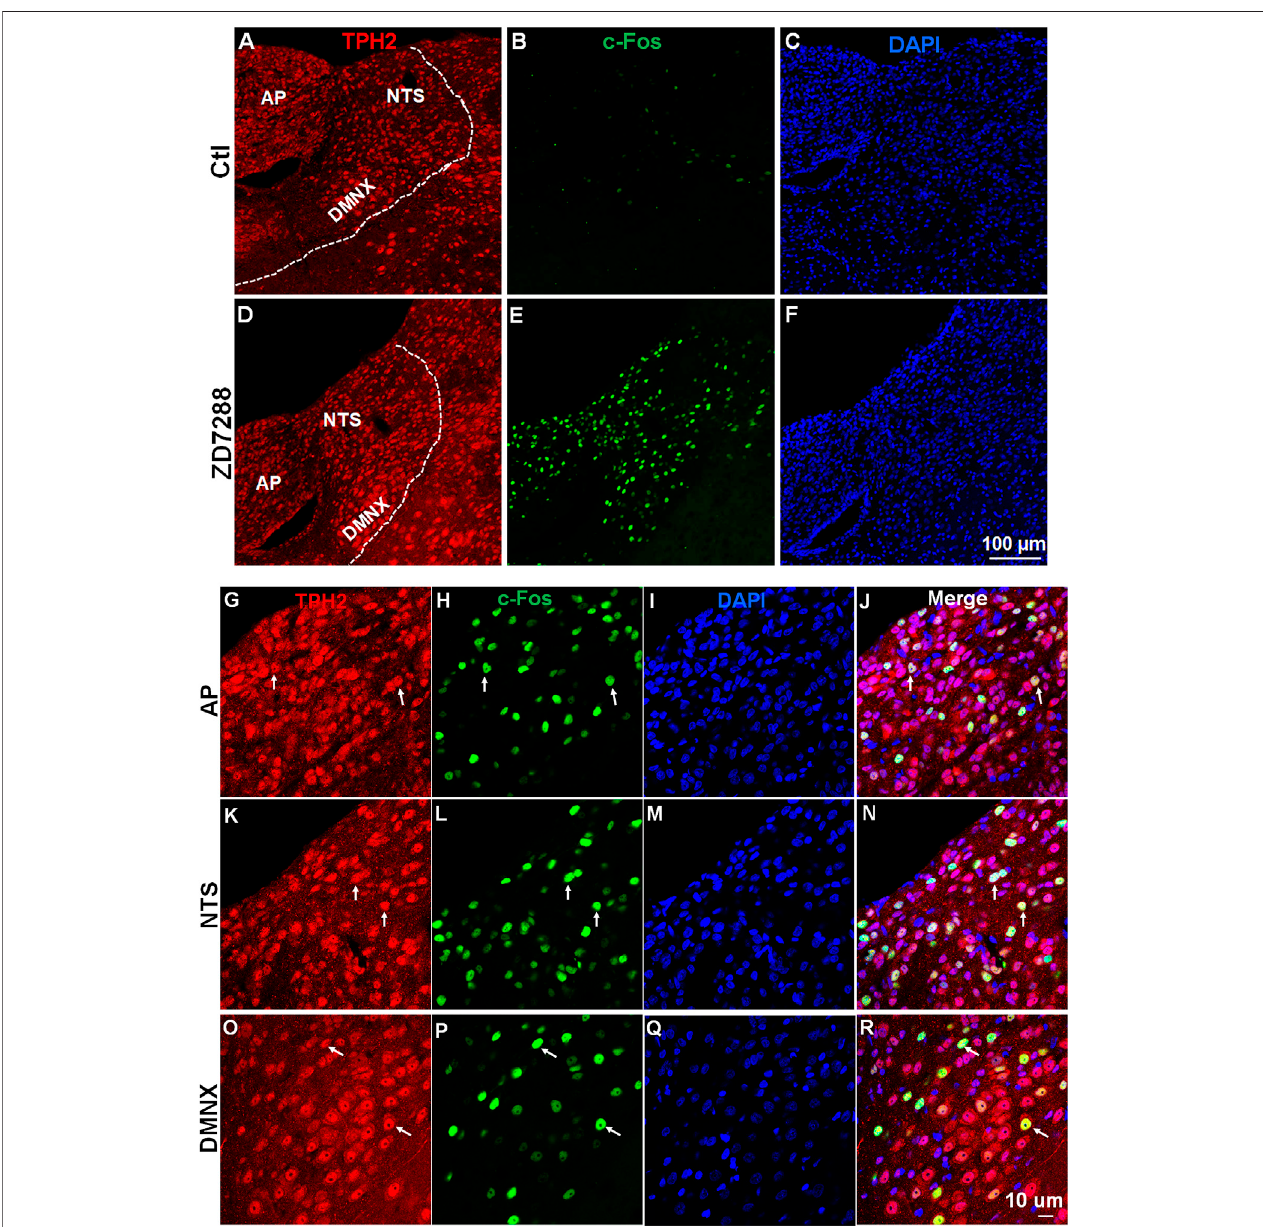
FIGURE7| ZD7288increasesc-Fosexpressionofserotoninneuronsintheleastshrewbrainstemdorsalvagalcomplex. (A – F) Tryptophanhydroxylase2(TPH2)is therate-limitingenzymeinthesynthesisofneuronalserotonin.Representativeimages(20x)showinganti-TPH2,anti-c-Fosandmergedimmuno fl uorescencestainingin vehiclecontrolsandshrewsadministeredwithZD7288(1 mg/kg,i.p.)( n (cid:2) 3shrewspergroup).Scalebars (cid:2) 100 μ m.(G – R)Representativehighermagni fi cationimages ( × 60)showingc-FosexpressingevokedbyZD7288(1 mg/kg,i.p.)localizedinTPH2positiveserotoninneuronsofthebrainstemdorsalvagalcomplex,composed of the area postrema (AP), the nucleus tractus solitarius (NTS) and the dorsal motor nucleus of the vagus (DMNX). Scale bars (cid:2) 10 μ m.